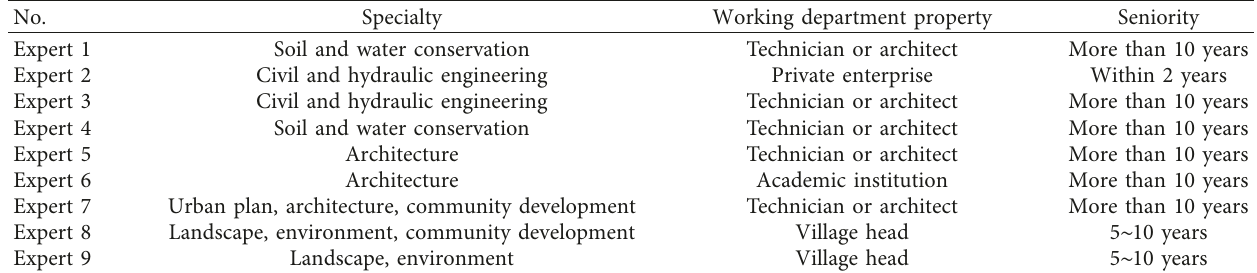
Table 3: Background of the experts involved with the expert questionnaire.